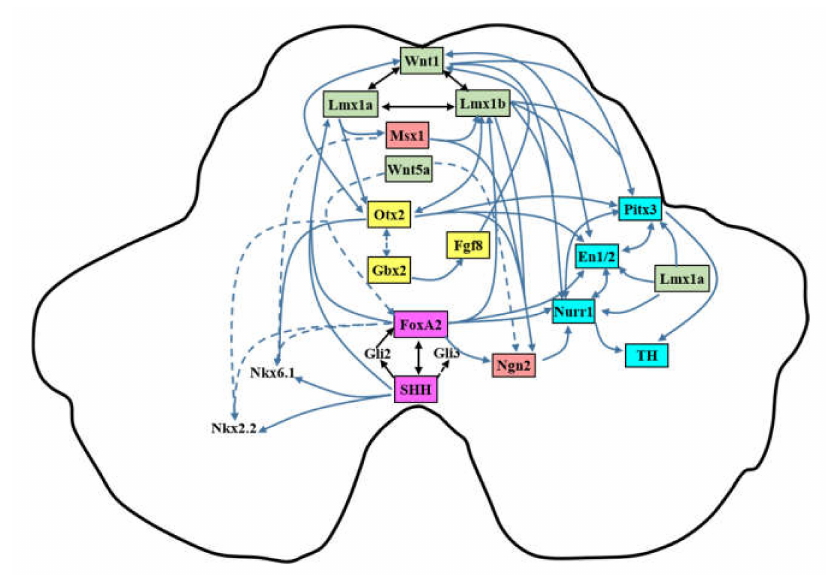
Figure 4. Genetic regulation of transcription factors in the development of the mDA neurons: The transcription factors are color-coded according to their expressions: purple = floor plate marker, yellow = midbrain–hindbrain boundary (MHB)-related genes, green = roof plate marker, red = neurogenesis marker, and blue = marker of postmitotic mDA neuron. The solid line denotes positive regulation; the dotted line means inhibition. FoxA2 is induced by Sonic hedgehog (SHH)